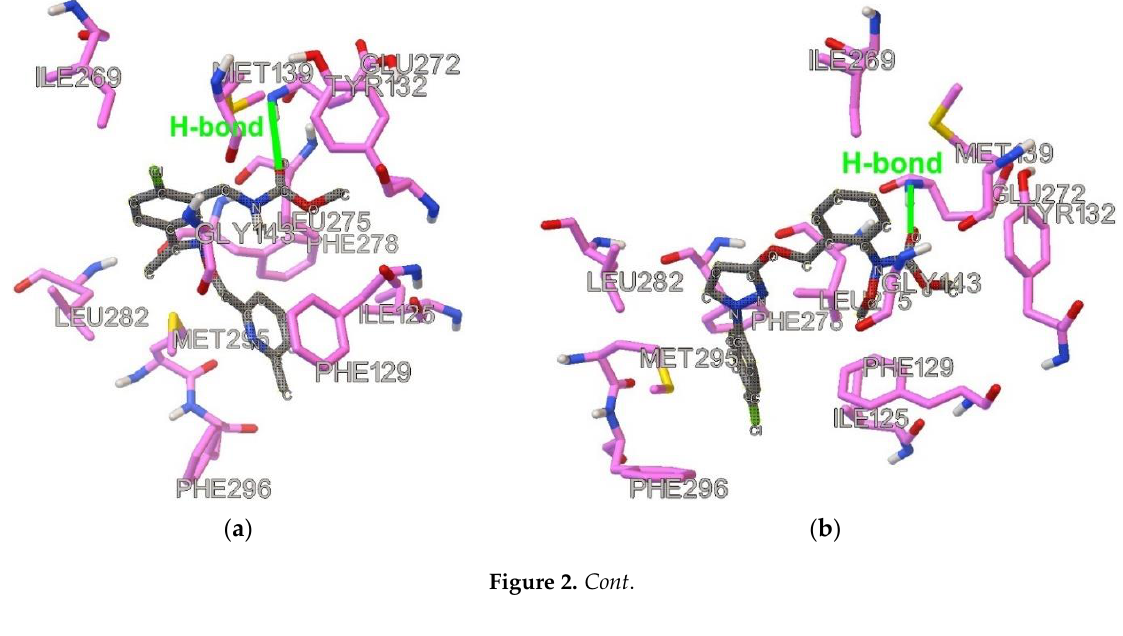
Scheme 2. Obtaining lead QoI of cytochrome bc1 for COCONUT drug recognition (drug discovery) pipeline.